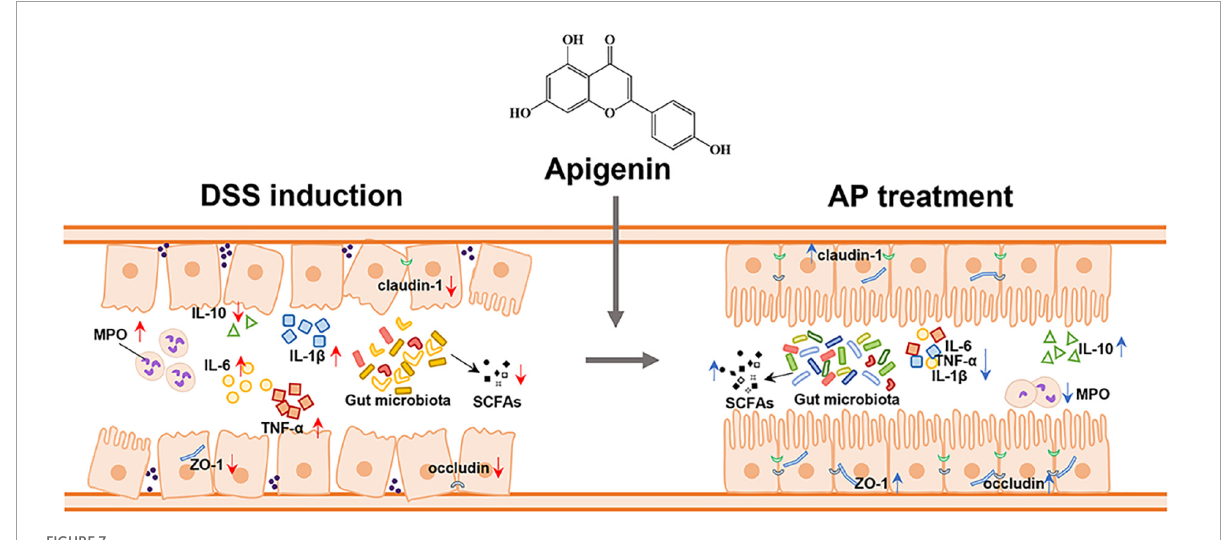
FIGURE7 Apigenin effectively ameliorated DSS-induced ulcerative colitis by balancing the gut microbiome structure and its metabolites (SCFAs) to inhibit the inflammatory response and protect the gut